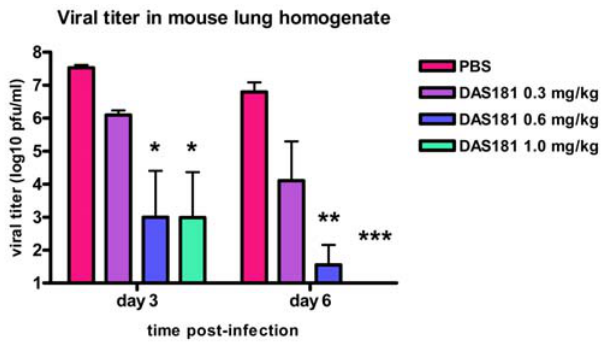
Figure 6. DAS181 inhibits pandemic IFV A(H1N1) viral replication in mice. BALB/c mice were inoculated with the pandemic influenza A(H1N1) virus A/Mexico/4108/2009 (1000 MID 50 /mouse, i.n. ). The mice were treated with PBS or DAS181 (0.3, 0.6, or 1 mg/kg) q.d.x5 , beginning 6 hours post-infection. Lungs were harvested on day 3 and day 6 p.i.. Viral titer in lung homogenate was determined by standard plaque assay on MDCK cells. Values represent mean 6 SEM viral titer amongst 3 mice per group/day. PFU=plaque forming units. No virus was detectable on day 6 in the DAS181 1.0 mg/kg treatment group. Statistical significance from PBS treatment determined by ANOVA with Bonferroni post-test, *=p , 0.05, **=p , 0.01, ***=p , 0.001. The limit of detection is 100